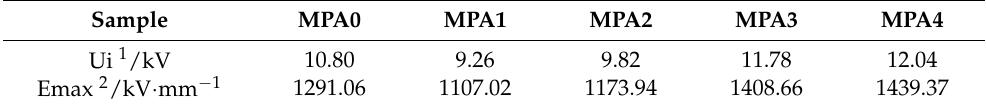
Table 1. Initiation voltages and initiation field strengths of electrical trees from different co-mixing ratios.